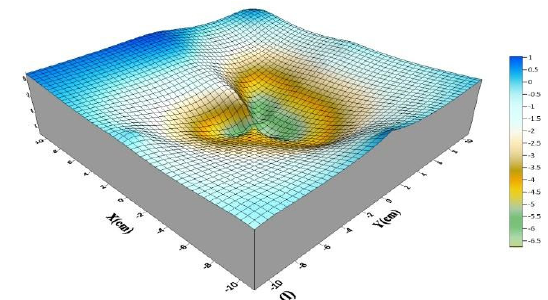
Fig. 7(l): The Scour and Deposition Pattern around Pier (P 1 ) at angle 15 0 and flowrate 18 L/Sec. The green area denotes